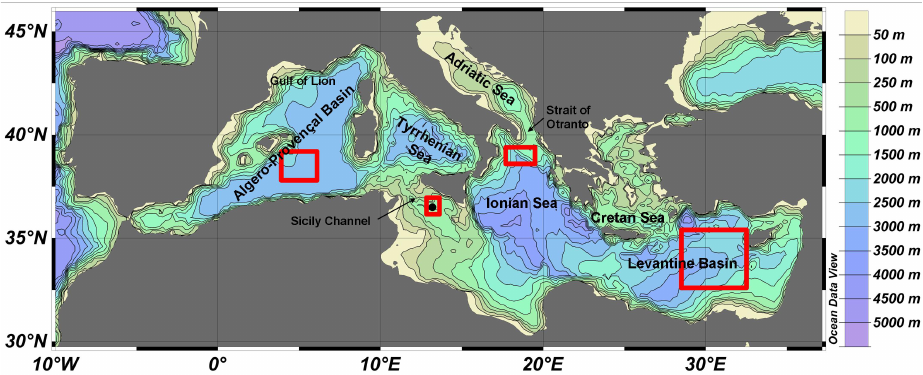
Fig. 1. Map of the Mediterranean Sea. Areas where the mean salinity values were calculated are delimited by continuous red lines. CTD measurement site in the Sicily Channel is denoted by a black